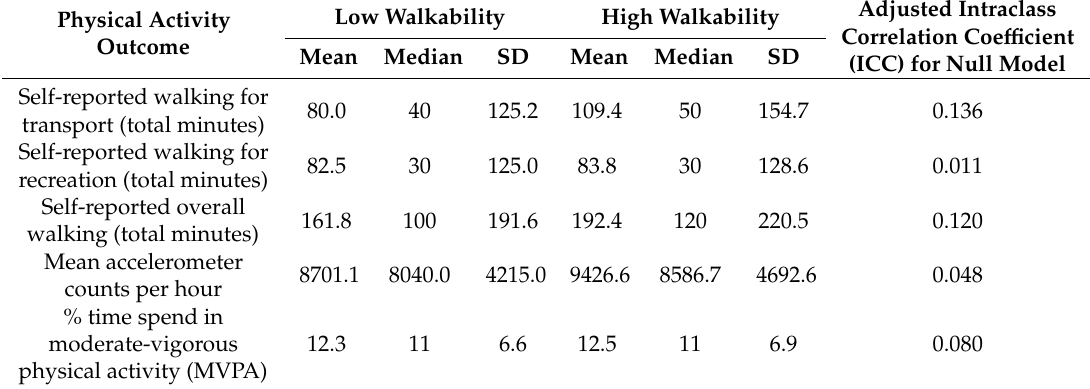
Table 2. Descriptive statistics for the physical activity outcome measures assessed over a 7-day period.